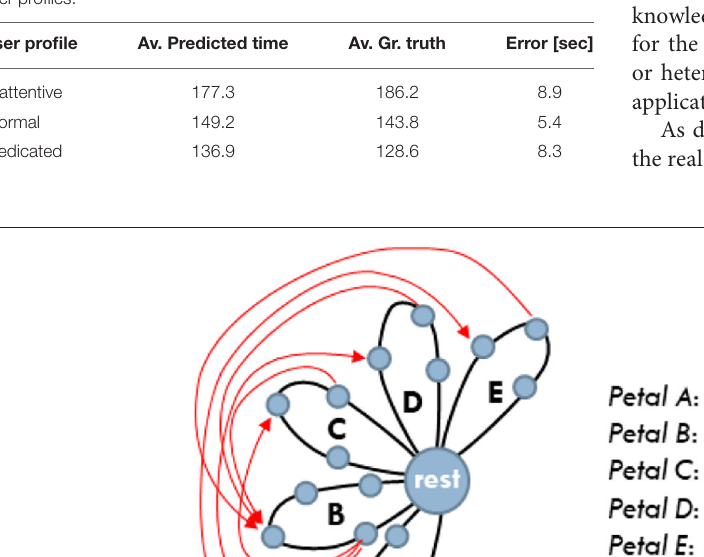
Frontiers in Robotics and AI |